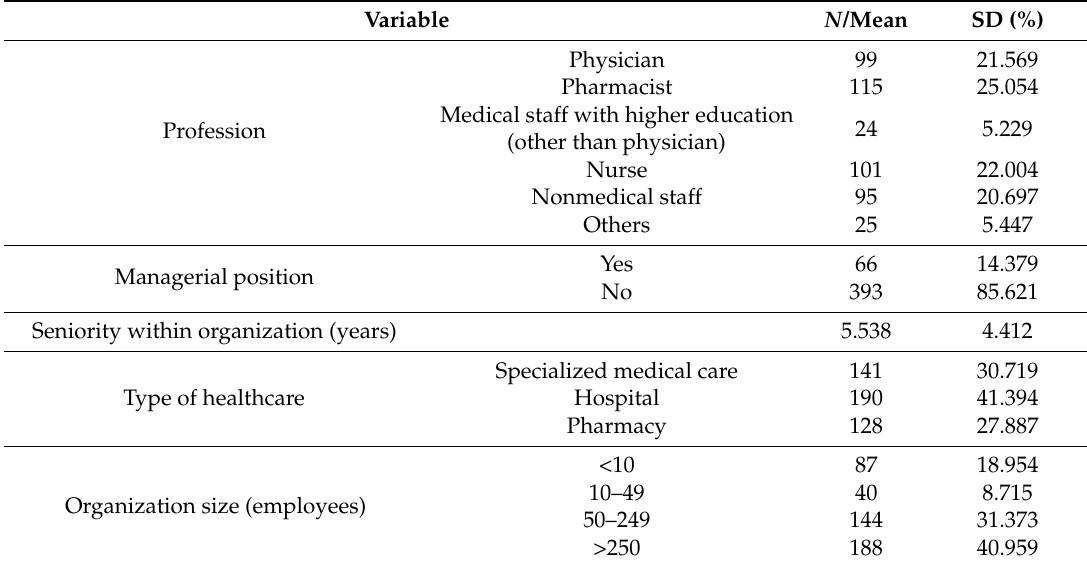
Table 1. Professional and organizational characteristics of the sample ( N =